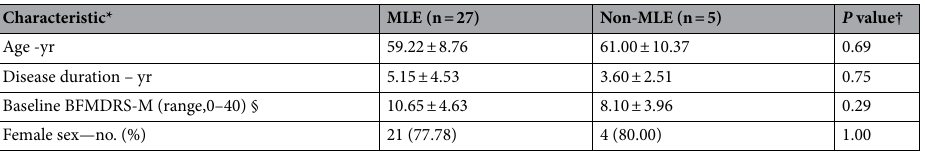
Table 1. Baseline characteristics of the patients. *Plus–minus values are means ± SD· † P values were calculated with the use of Student’s t-test or analysis of variance for continuous variables and Fisher’s exact test for categorical variables. § A higher score indicates worse functioning.